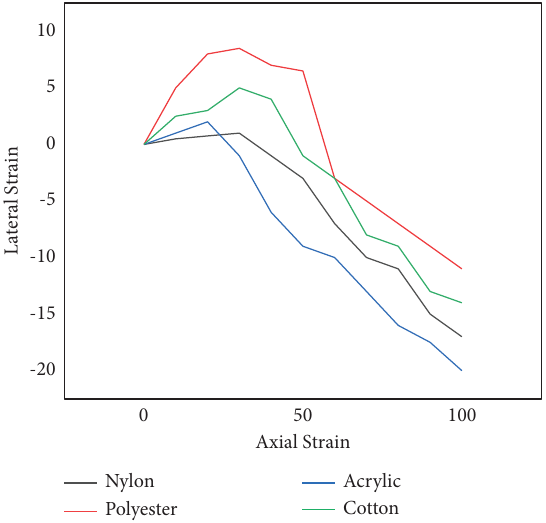
Figure 17: Course-wise expansion in line structures on the ap- plication of force.